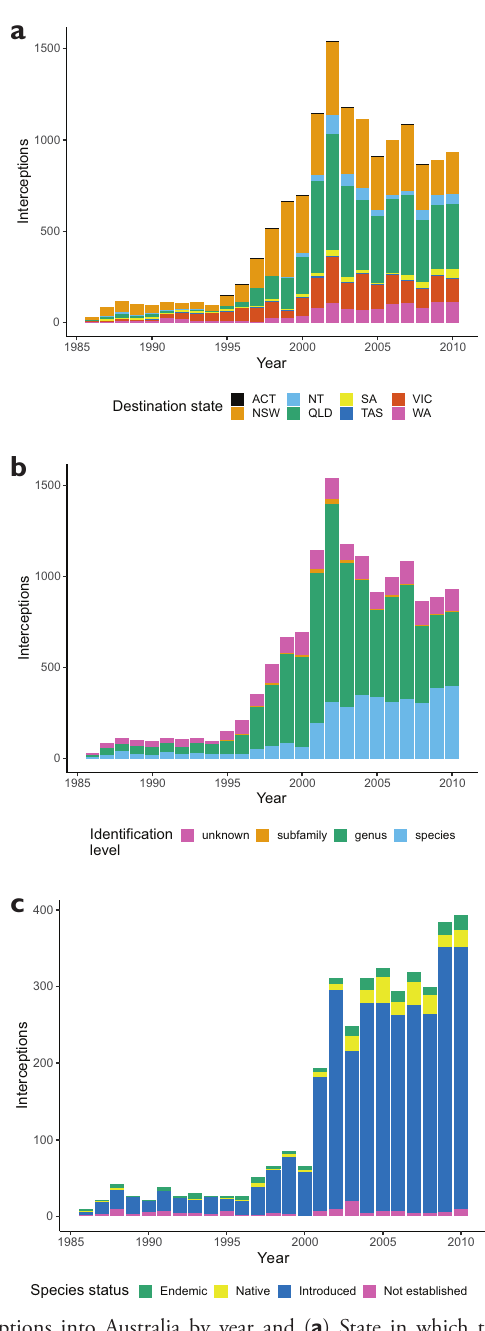
Figure 1. Ant interceptions into Australia by year and ( a ) State in which the interception occurred (ACT = Australian Capital Territory, NT = Northern Territory, SA = South Australia, VIC = Victoria, NSW = New South Wales, QLD = Queensland, TAS = Tasmania, WA = Western Australia), ( b ) taxonomic level the interception was identified to, and ( c ) species status for records that were identified to species